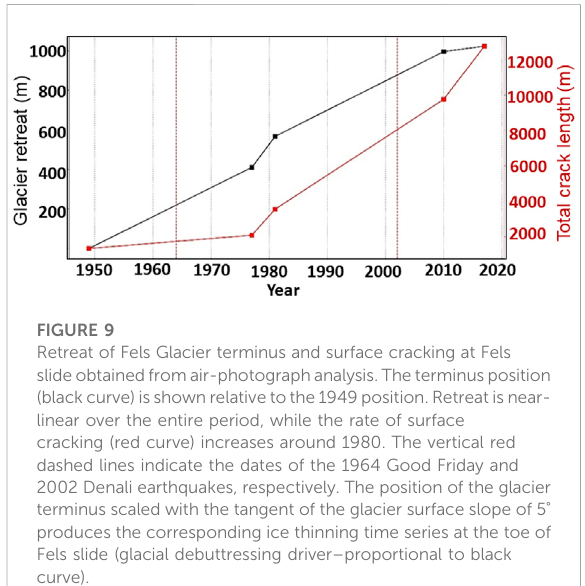
FIGURE 9 Retreat of Fels Glacier terminus and surface cracking at Fels slideobtainedfromair-photographanalysis.Theterminusposition (blackcurve)isshownrelativetothe1949position.Retreatisnear- linear over the entire period, while the rate of surface cracking (red curve) increases around 1980. The vertical red dashed lines indicate the dates of the 1964 Good Friday and 2002 Denali earthquakes, respectively. The position of the glacier terminus scaled with the tangent of the glacier surface slope of 5 ° produces the corresponding ice thinning time series at the toe of Fels slide (glacial debuttressing driver – proportional to black